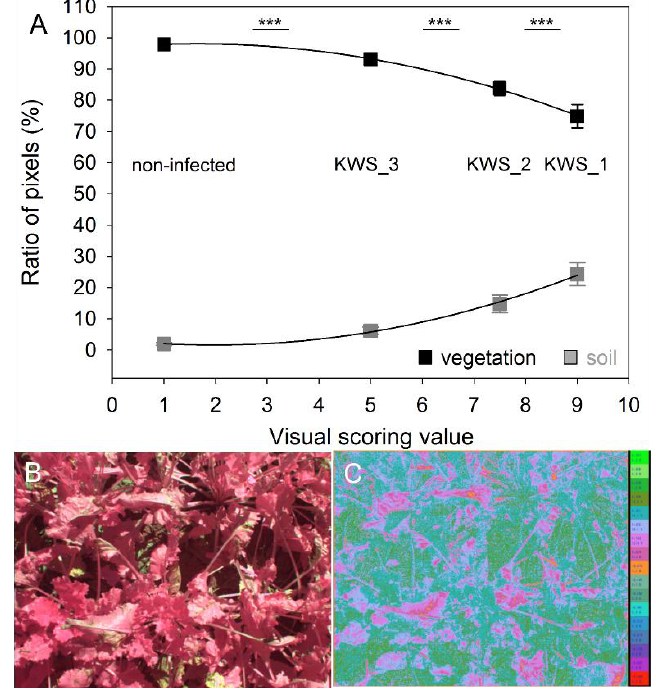
Figure 2. Tetracam images of Cercospora Leaf Spot (CLS) infected sugar beets; ( A ) ratio of pixels with Normalized Differenced Vegetation Index (NDVI) < 1 (soil) or NDVI ≥ 1 (vegetation) for plots with sugar beet plants of genotypes KWS_1, KWS_2, and KWS_3 inoculated with Cercospora beticola as well as disease-free plants in correlation to visual disease scoring. Regression was calculated using 2nd degree polynomial fit. Pixel ratios of the three genotypes differ significantly ( *** ANOVA, p < 0.001) from each other; ( B ) representative multispectral image of infected beet plants; ( C ) color coded NDVI image calculated out of image ( B ) using Tetracam PixelWrench2.